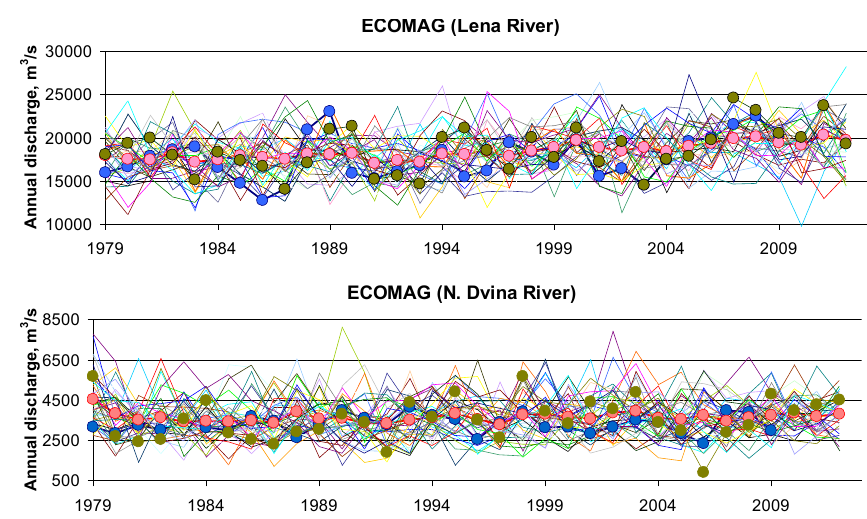
Figure 11. Observed (line with blue markers) and simulated series of annual discharges. Thin lines show the ensemble (45 realizations) of the calculated annual discharges. The line with red markers shows the ensemble mean. The line with green markers shows the realization most strongly correlated with the observed time